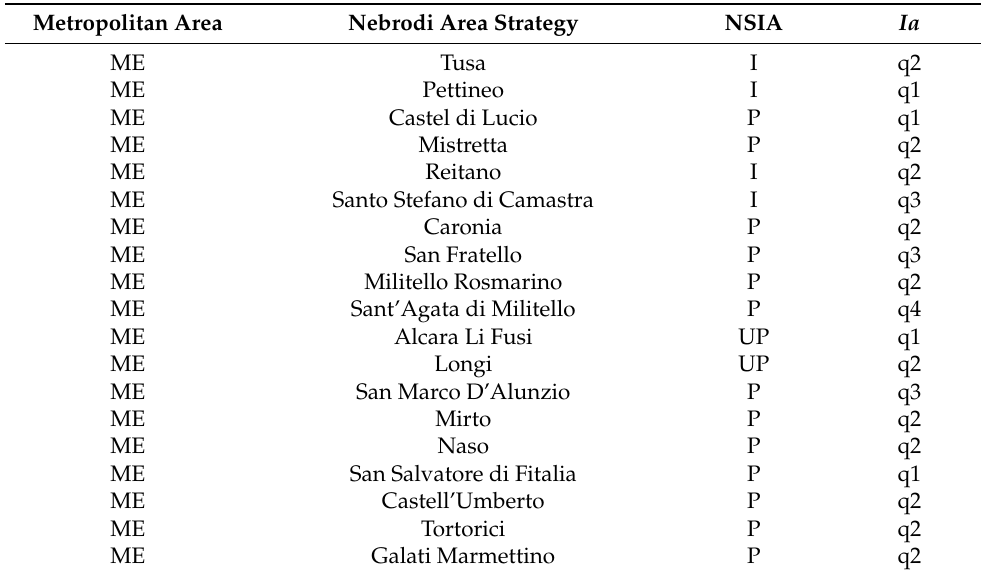
Table 8. The municipalities belonging to the Nebrodi area